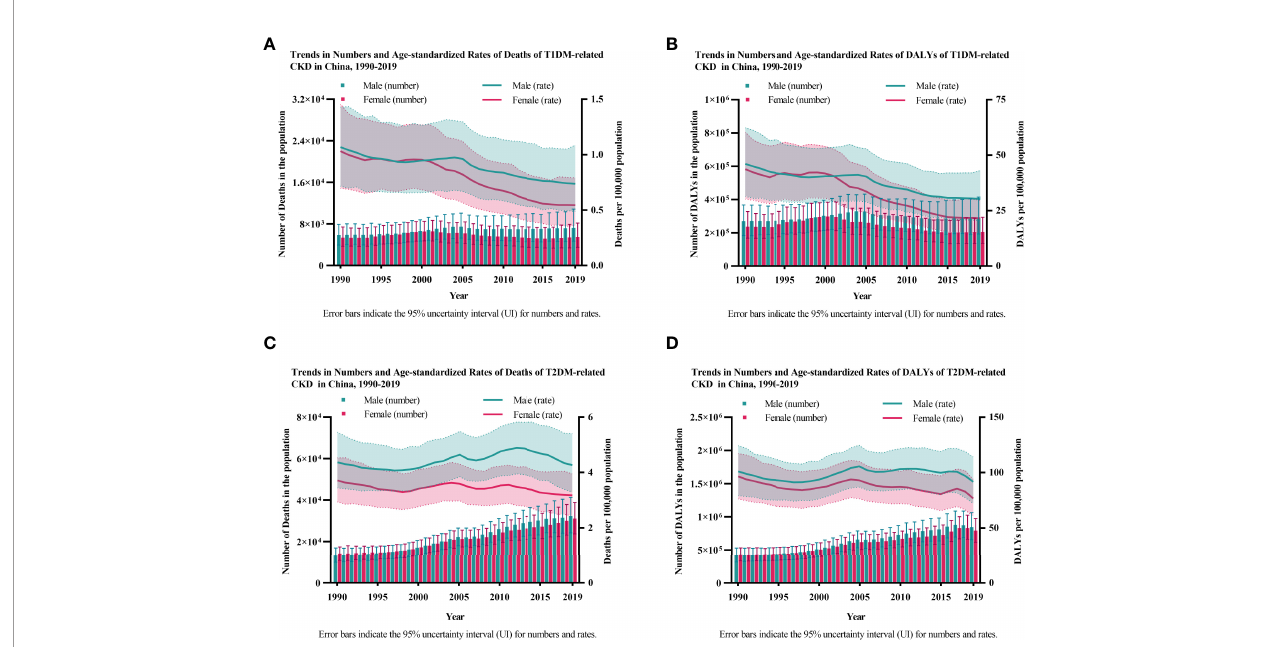
FIGURE 1 | The burden of diabetes-related CKD by year from 1990 to 2019. (A, B) show the numbers and age-standardized rates of deaths and DALYs of T1DM- related CKD. (A) Deaths; (B) DALYs; (C, D) show the numbers and age-standardized rates of deaths and DALYs of T2DM-related CKD. (C) Deaths; (D) DALYs; CKD, chronic kidney disease; T1DM, type 1 diabetes mellitus; T2DM, type 2 diabetes mellitus; DALYs, disability-adjusted